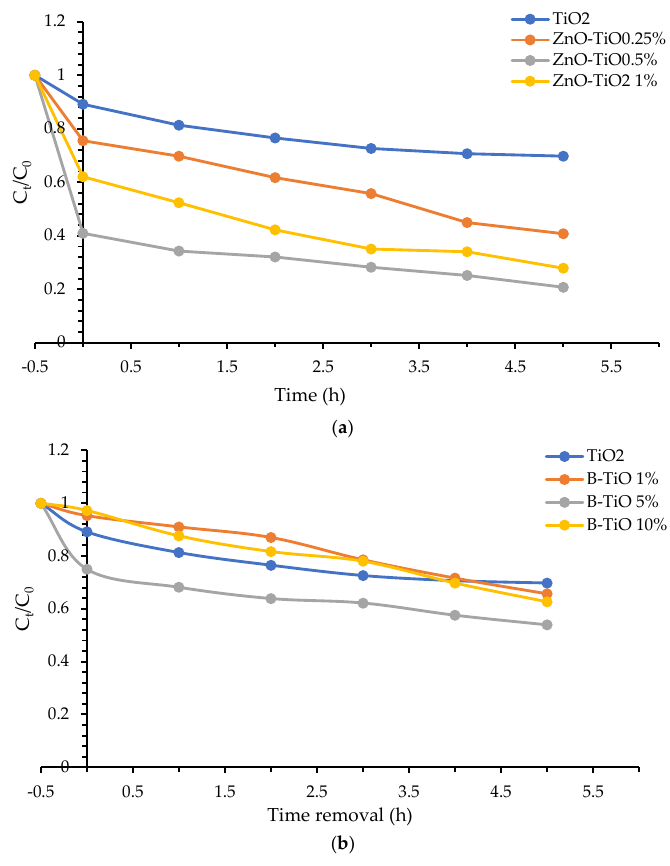
Figure 1. Effect of ZnO loading ( a ) and B loading ( b ) in the nanocomposite on dye removal efficiency.